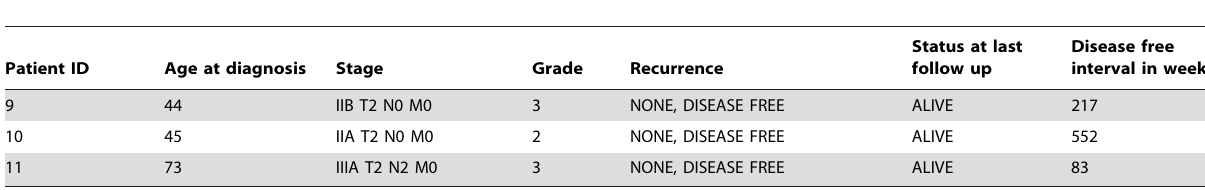
Table 4. Characteristics of NY-ESO-1 positive TNBC patients without NY-ESO-1 antibodies.